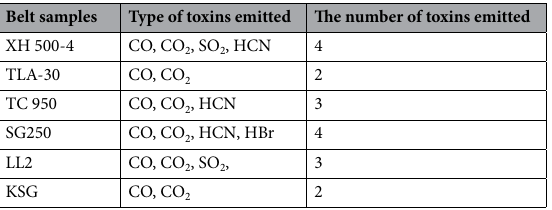
Table 2. The type and number of toxins emitted during the combustion of the tested